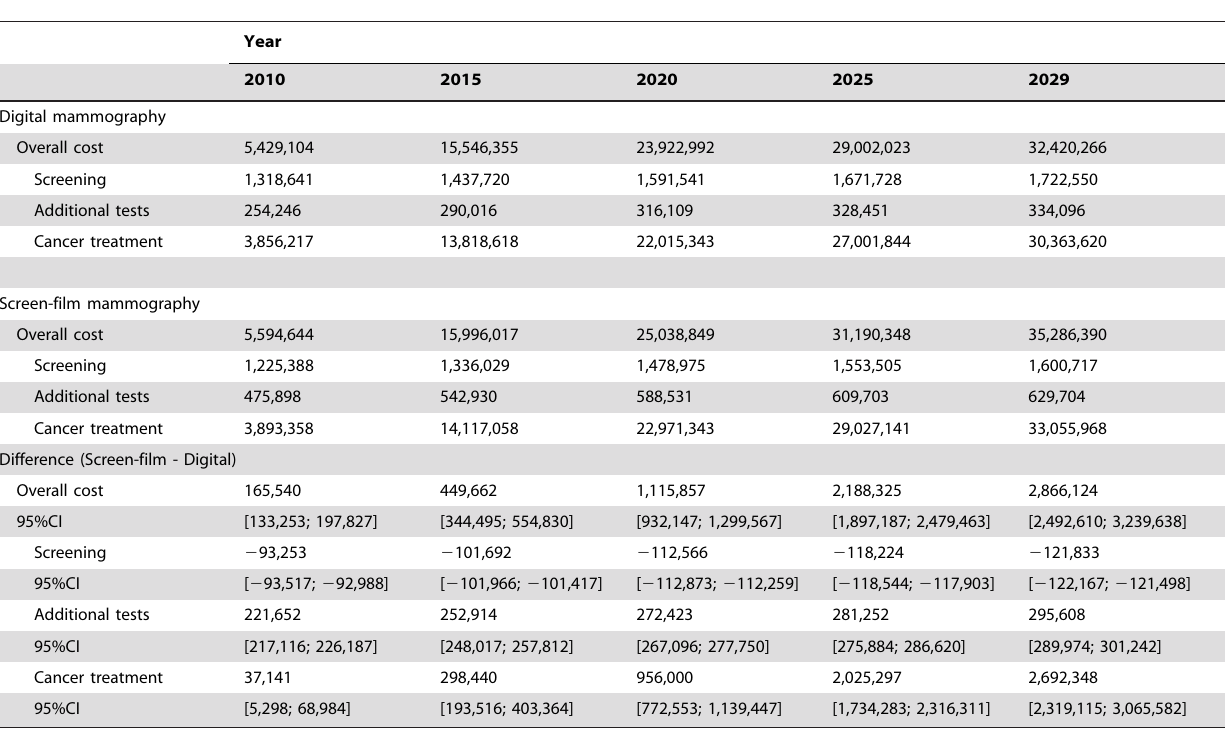
Table 3. Budget impact analysis of digital mammography compared with screen-film